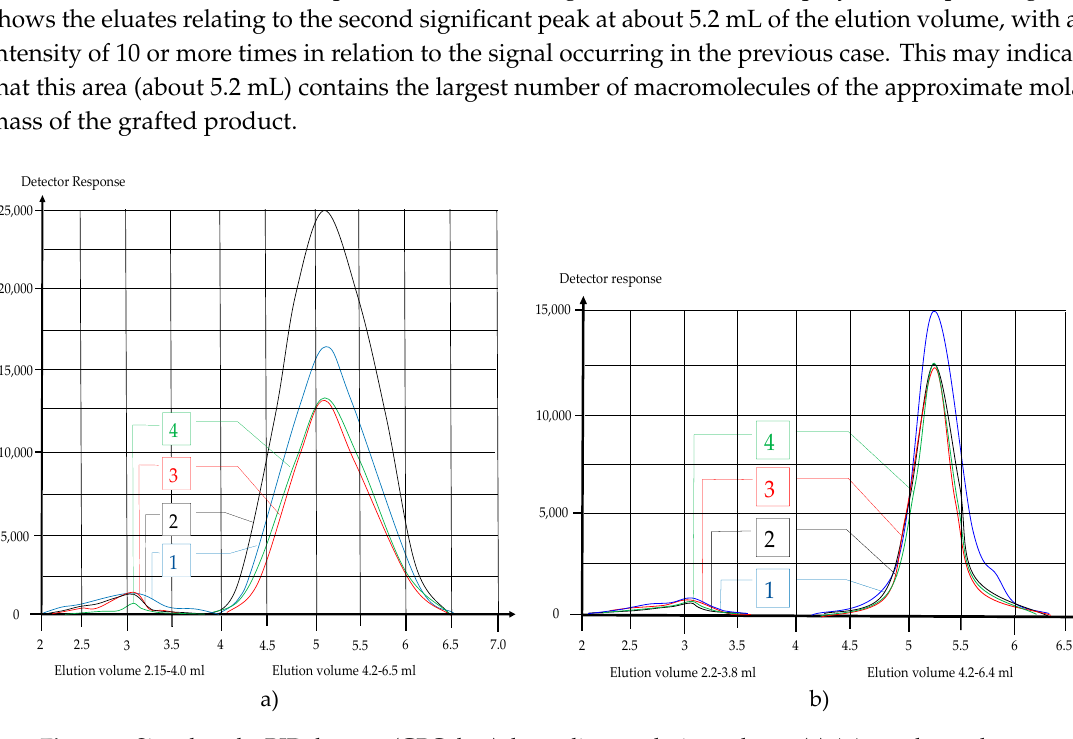
Figure 5. Signal on the RID detector (GPC data) depending on elution volume, ( a ) AA starch copolymer; ( b ) HEMA starch copolymer, 1—HS-AA-AIBN, 2—HS-AA-BP, 3—HS-AA-KPS, 4—HS.